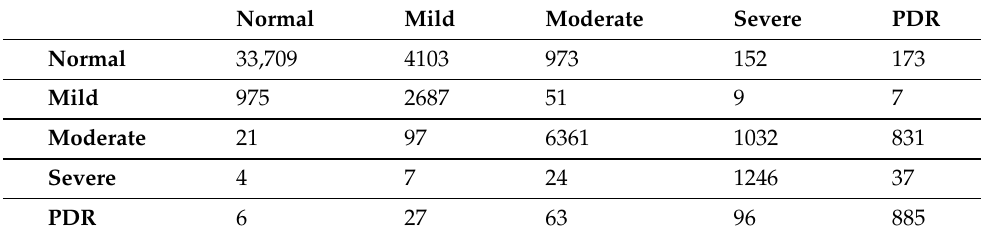
Table 9. Confusion matrix For averaged probability results of ensemble architecture, accuracy = 83.78%.